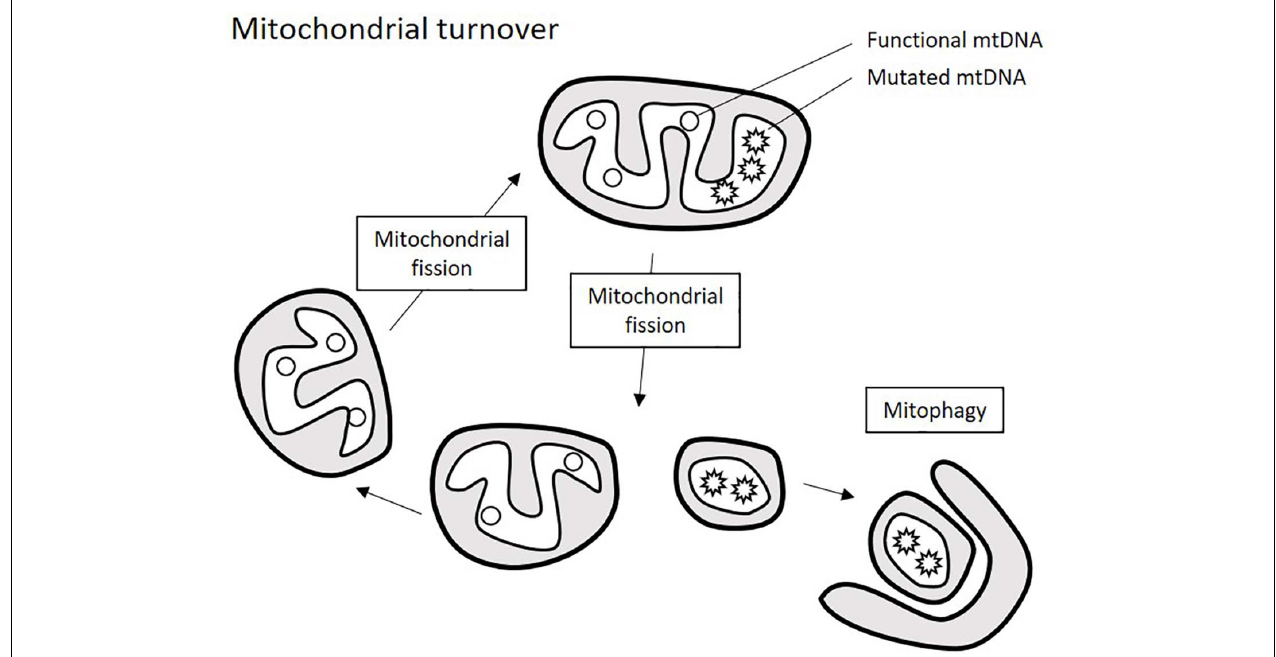
FIGURE 2 | Schematic presentation of mitochondrial turnover. Mitochondria ungergo cycles of fission and fusion events that allow renewing mitochondrial population. Excessive or defective parts of the mitochondria are degraded through mitophagy, which requires prior fragmentation of them by mitochondrial